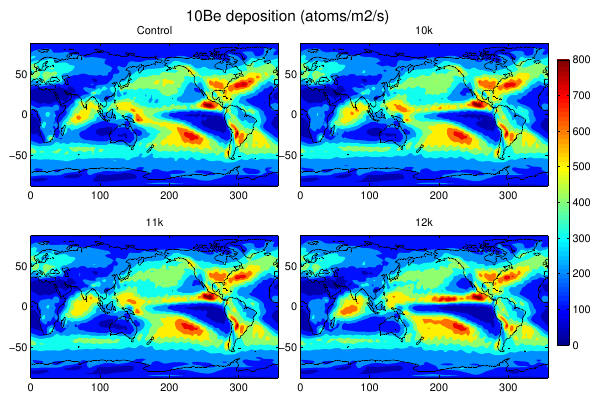
Fig. 1. Mean 10 Be deposition (atomsm − 2 s − 1 ) in the simulations.